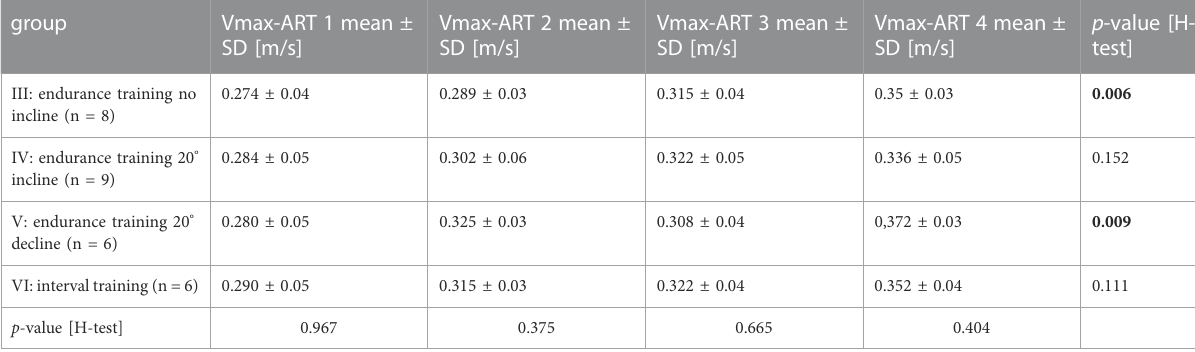
TABLE 1 Treadmill training led to increased running speeds group